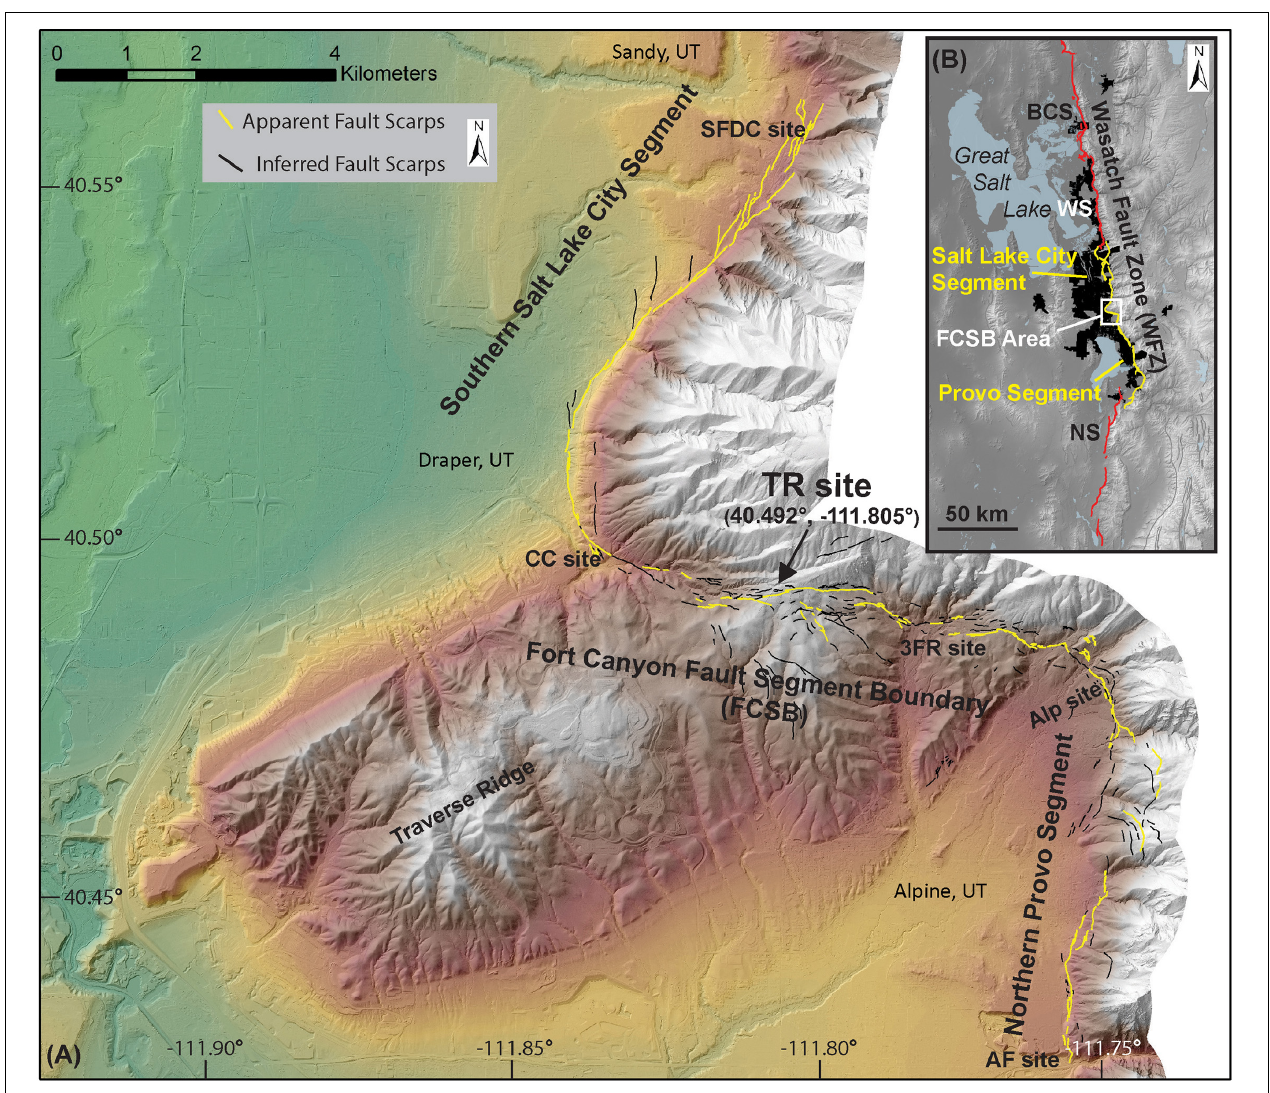
FIGURE 1 | (A) The Fort Canyon segment boundary (FCSB) is the fault linking the Salt Lake City and Provo segments of the Wasatch fault zone (WFZ). Within the segment boundary the fault trace (yellow and black lines) is more complex than the adjacent fault segments (Toké et al., 2017). The Traverse Ridge site (TR site: this paleoseismic study) is located at the crest of Traverse Ridge, midway along the FCSB. Adjacent paleoseismic sites include the South Fork Dry Creek site (SFDC site: Schwartz and Lund, 1988; Black et al., 1996), the Corner Canyon site (CC site: DuRoss et al., 2018), the Three Falls Ranch site (3FR site: Western GeoLogic, 2004), the Alpine site (Alp site: Bennett et al., 2018), and the American Fork site (AF site: Forman et al., 1989). (B) The WFZ extends for more than 300 km along the urban areas of the Wasatch Front (black regions). This study focuses on the Salt Lake City and Provo fault segments (yellow lines) which cut along the eastern edge of the urbanized area, within 10 km of more than 50% of Utah’s residents. Other segments (red lines) of the central WFZ include the Brigham City segment (BCS), the Weber segment (WS), and the Nephi segment (NS). The FCSB study area (A) is shown with a white box. Waterbodies (blue) and other Quaternary active faults are shown as faint gray lines over a shaded relief base